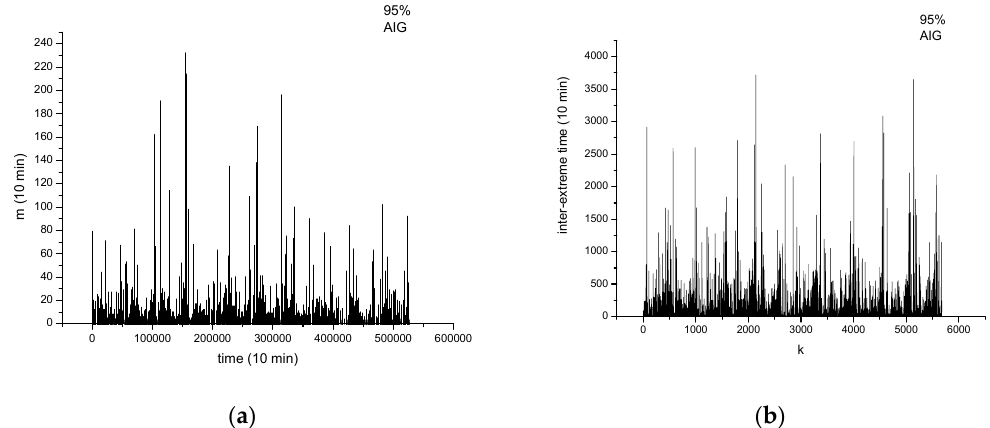
Figure 2. Sequence of wind extremes (for the threshold of 95th percentile of the distribution of the wind speed) for the station AIG at 381 m a.s.l.: ( a ) durations m and ( b ) inter-extreme times.